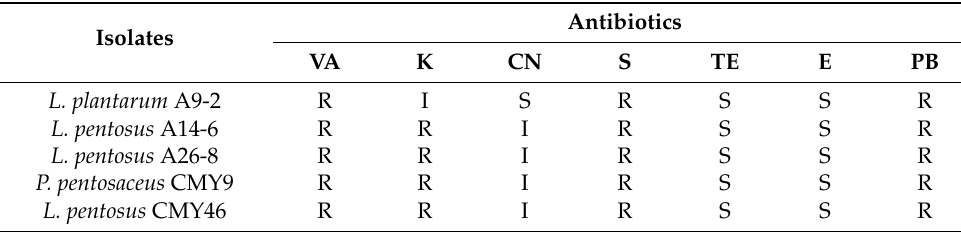
Table 3. Susceptibility of LAB isolates to antibiotics.